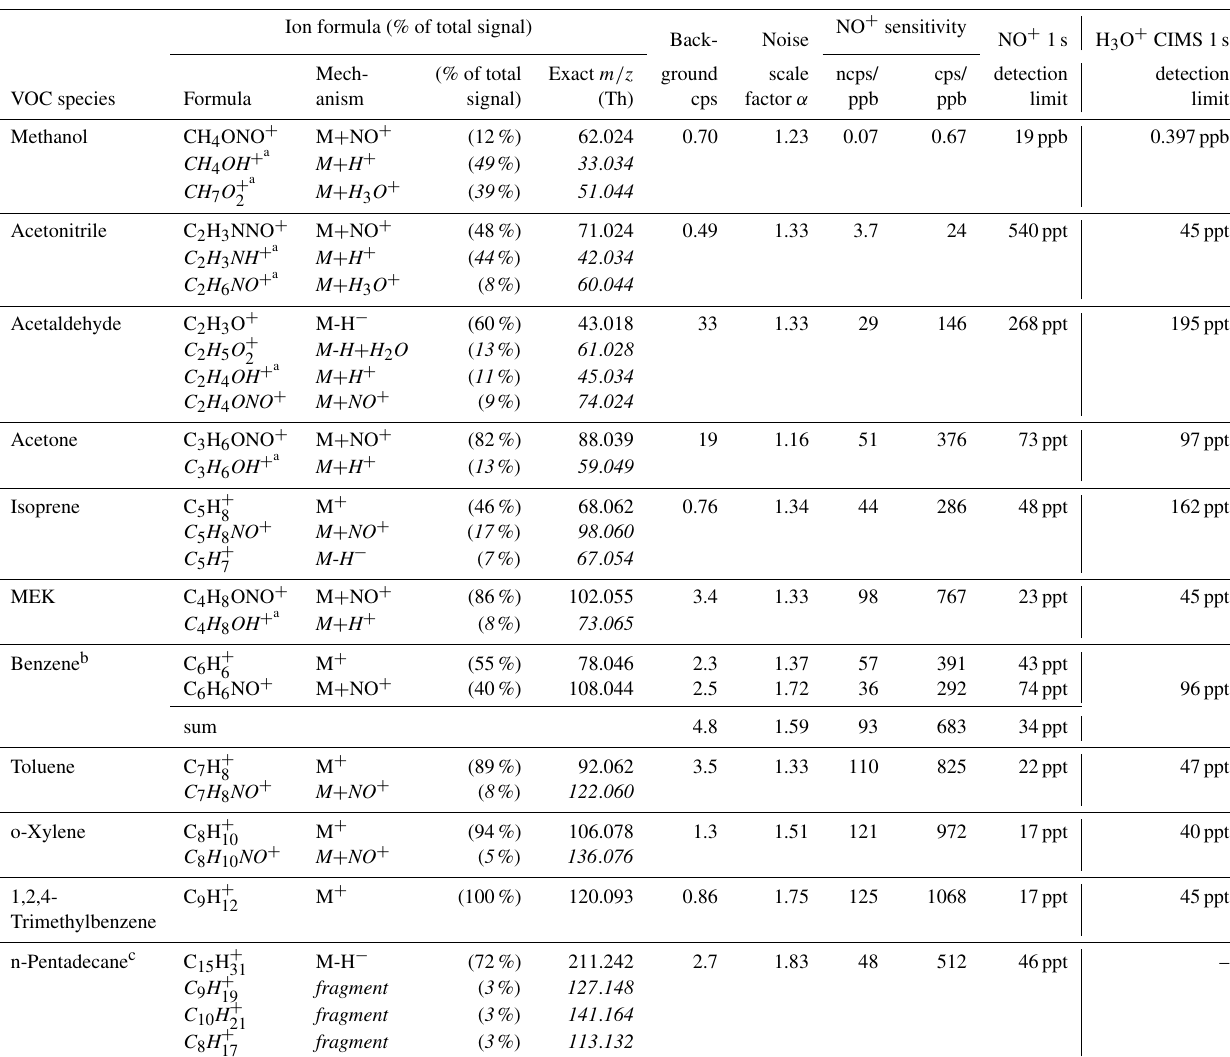
Table 2. Sensitivities and detection limits of NO + ToF-CIMS for various VOCs. Additional product ions not used to establish sensitivity are listed in italic. The H 3 O + ToF-CIMS detection limits in the farthest right column are calculated from separate H 3 O + ToF-CIMS calibrations as described in Yuan et al.